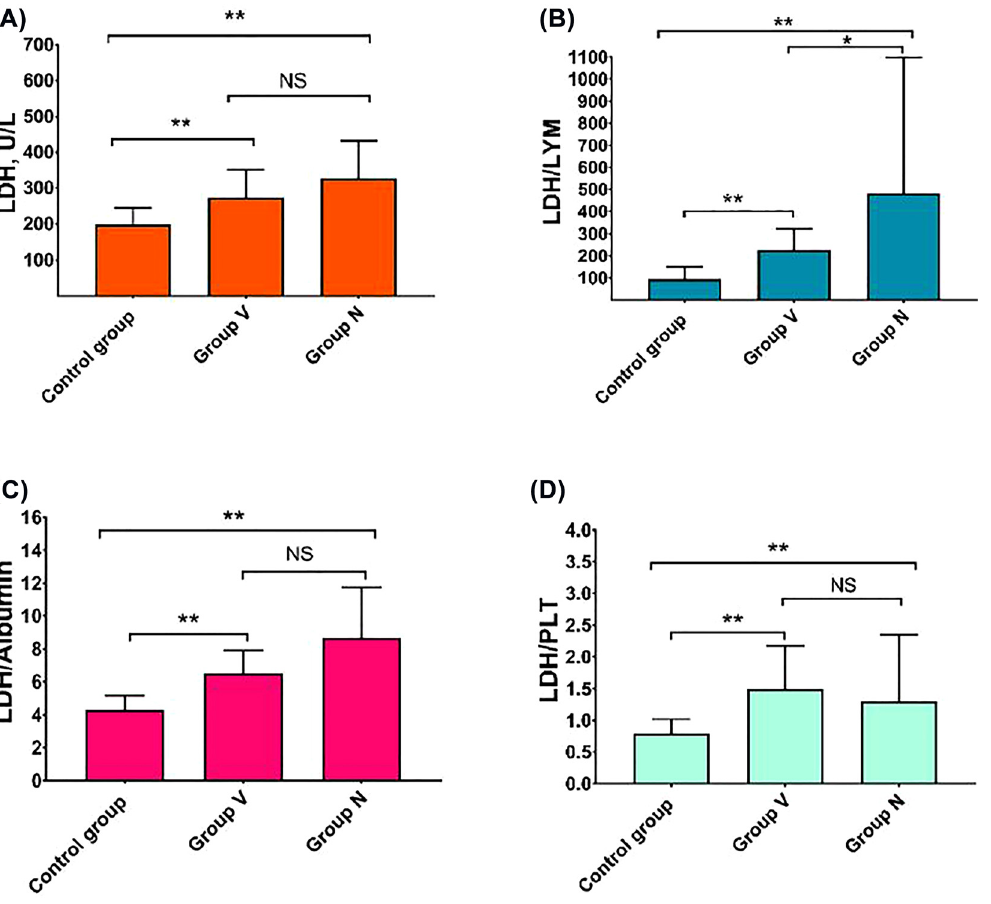
Figure 1: Comparison of LDH (A), LDH/LYM (B), LDH/Albumin (C), LDH/PLT (D) levels of control group, Group V and Group N groups. p-Values less than 0.001 were considered signi fi cant highlighted in double asterisk. NS, not significant; PLT, platelet; and LYM, lymphocytes.